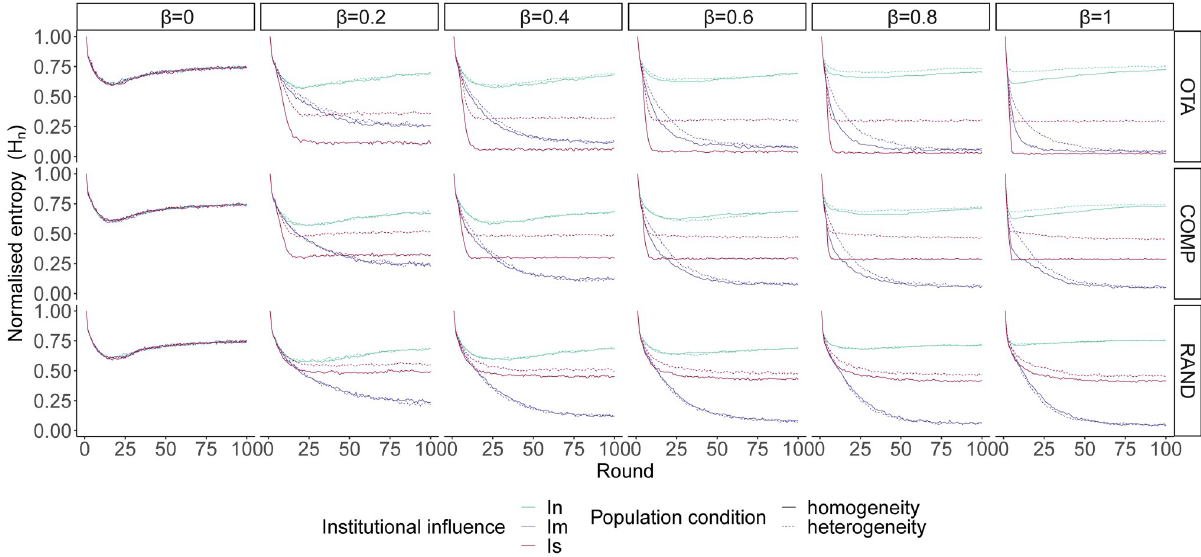
Fig 3. Opinion diversity (measured as normalised Shannon entropy) under value-aggregating institutions, averaged over each level of = neutral; I = moderate and I = strong), population homogeneity or heterogeneity and opinion value bias ( β ) under institutional influence ( I n m s three types of value systems: OTA (one takes all), COMP (competition between two opinions) and RAND (random). Agents tend to converge on a shared opinion when institutional influence is moderate. Under strong institutional influence the equilibrium tends to reflect the initial diversity of agents’ value systems in the population. Convergence on shared opinions accelerates as β increases.